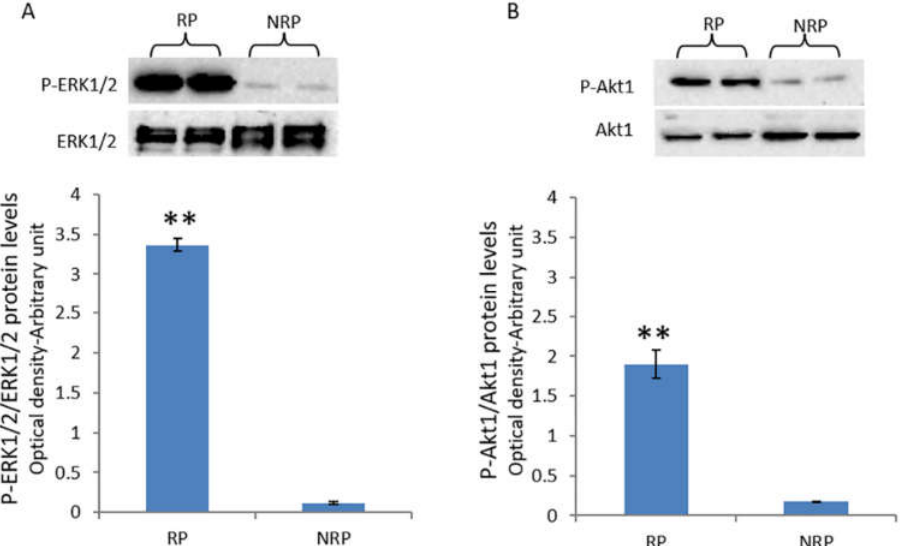
Figure 2. Expressions of P-ERK1/2 and P-Akt-1 in quail testis during reproductive and non- reproductive periods. ( A ) Detection of P-ERK1/2 protein using Western blot analysis. A specific band of 42 kDa was detected. The amount of phosphorylated ERK1/2 was quantified using the ImageJ program and normalized with respect to ERK1/2. The values presented represent the means ± S.D. of the values obtained for five samples (two bands were shown in the upper panel). ** p < 0.01. ( B ) Western blot analysis for Akt-1 protein in quail testis during reproductive and non-reproductive periods. A specific band of 60 kDa was detected. The amount of phosphorylated Akt-1 was quantified using the ImageJ program and normalized with respect to Akt-1. The values presented represent the means ± S.D. of the values obtained for five samples (two bands were shown). ** p < 0.01. RP, reproductive period; NRP, non-reproductive period.